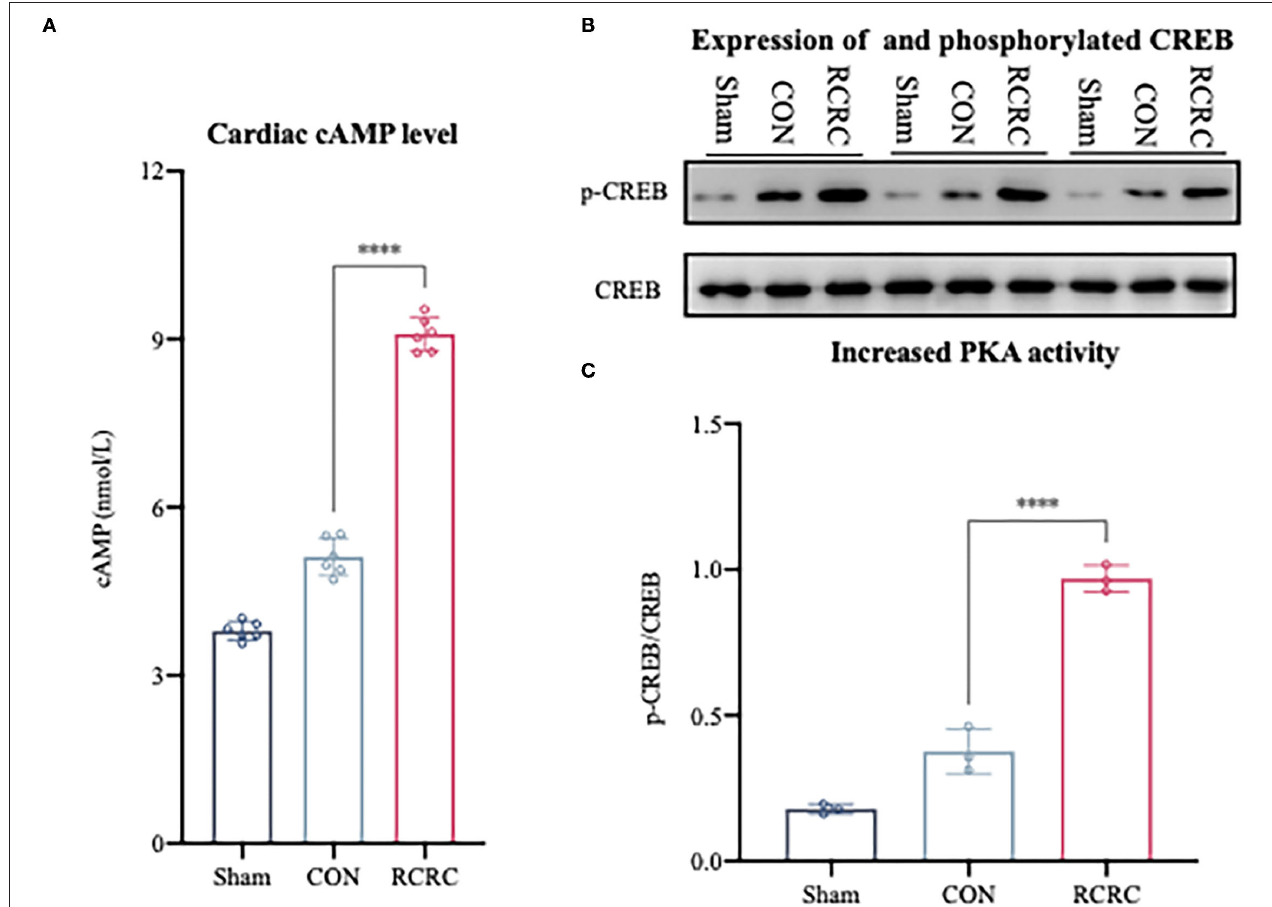
FIGURE 5 | Remote conditioning by rhythmic compression reduced cAMP content and PKA activity in heart of AMI rats. (A) Levels of cAMP in the heart of AMI rat were determined by ELISA, N = 6. (B,C) Levels of phosphorylated CREB (p-CREB) and total CREB in heart were detected by western blot. The corresponding quantification data of p-CREB to CREB ratio are shown in right panel. All values represent as means ± SD. N = 6. **** p < 0.0001 vs. CON.